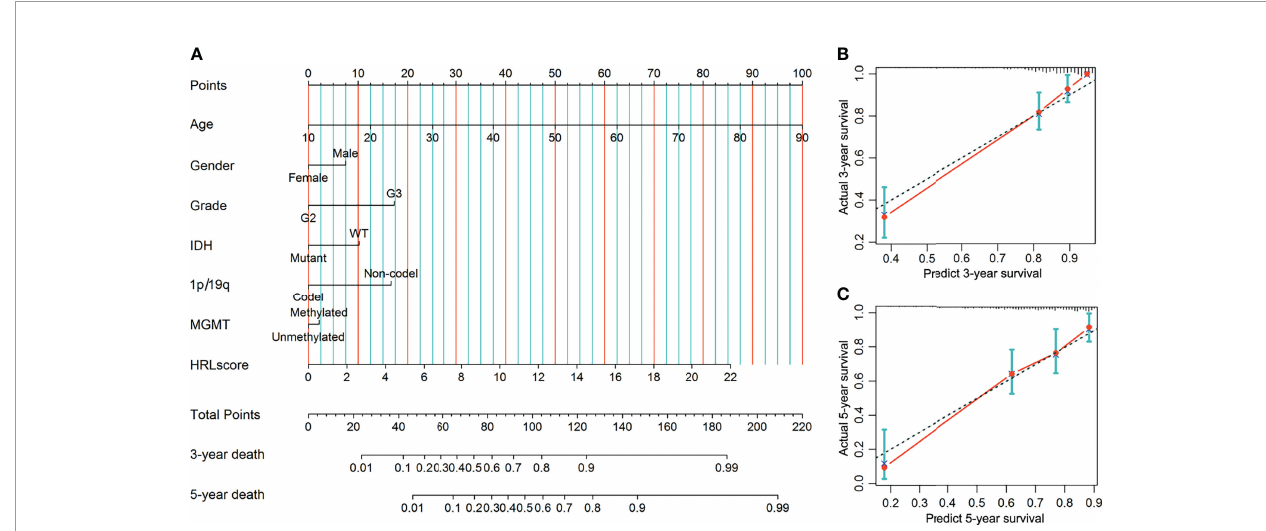
FIGURE 6 | Construction and evaluation of the nomogram in the TCGA-LGG cohort. (A) Nomogram based on the HRLscore and clinicopathologic variables. (B) The 3-year calibration plot for the nomogram. (C) The 5-year calibration plot for the nomogram.